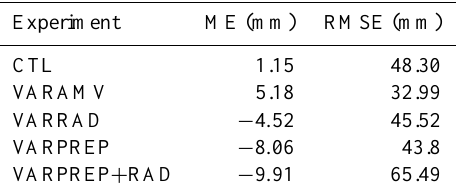
Table 4. Mean error (ME) and RMSE in simulated rainfall for all eight selected tropical